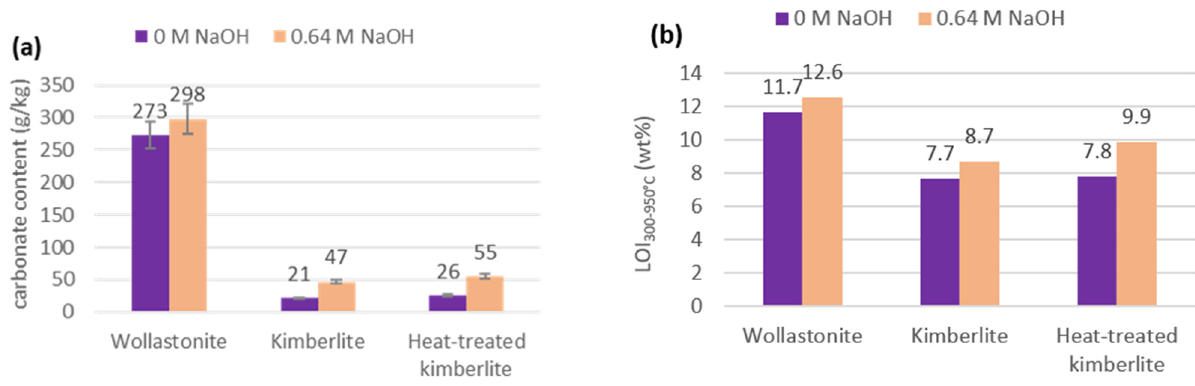
Figure 7. ( a ) Carbonate content (calcimeter mean accuracy: ± 7.6%) and ( b ) LOI 300–950 ◦ C of carbonated wollastonite and kimberlite through pressurized (4 h, 200 ◦ C, 60 bar CO 2 ). Carbonate content and CO 2 content (LOI 300–950 ◦ C ) of unreacted wollastonite are 41.7 g/kg and 0.80 wt%, respectively. Carbonate content and CO 2 content (LOI 300–950 ◦ C ) of unreacted kimberlite and heat-treated kimberlite are 19.5 g/kg and 7.3 wt%, and 9.0 g/kg and 4.7 wt%, respectively.